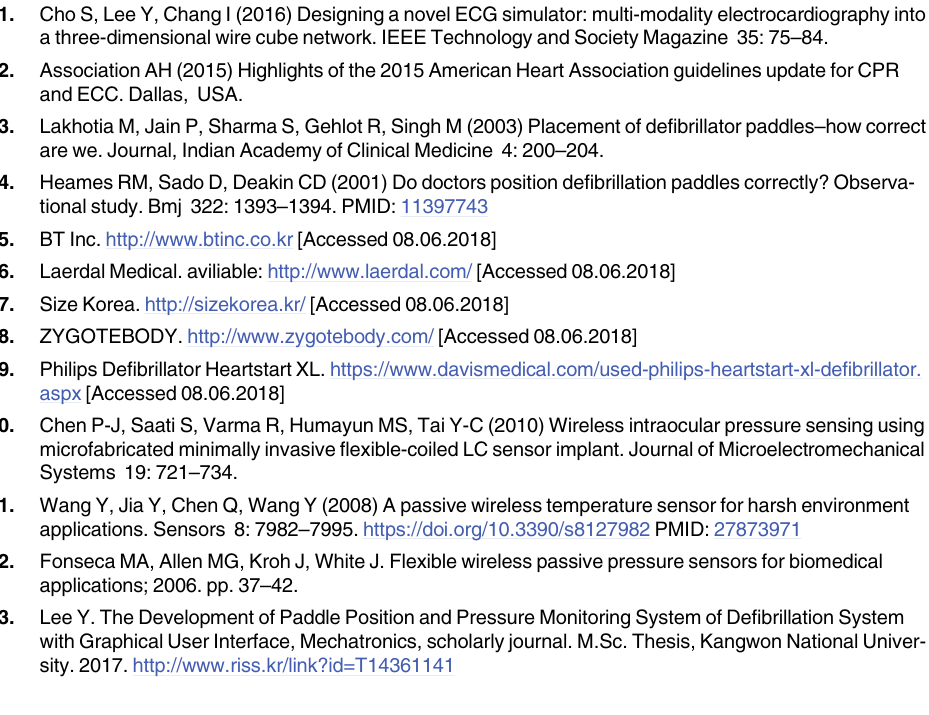
S1 Fig. Paddle 3D modeling